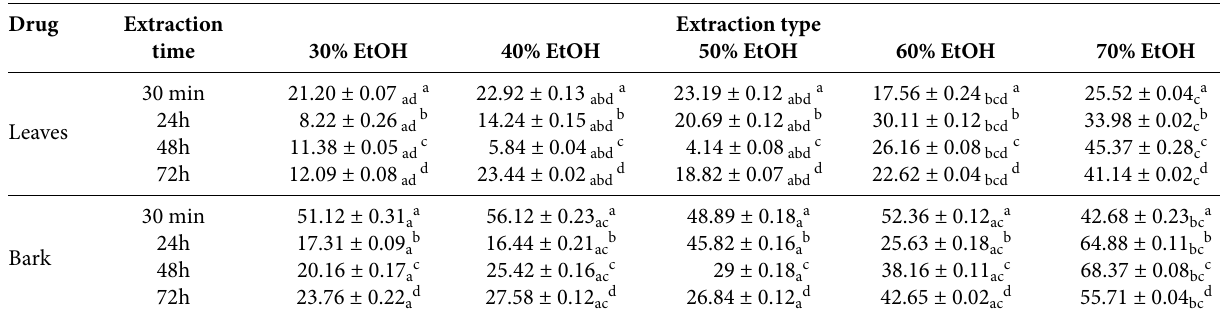
Table 3. Total phenolics content of S.caprea leaves and bark extracts [mg of gallic acid equivalents per g of dried extract] Drug Extraction